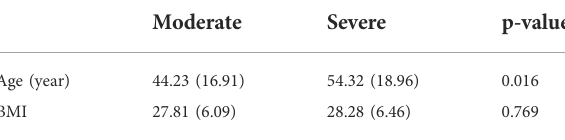
TABLE 2 Distribution of age and BMI among the disease groups (severe and moderate). Data show mean value (standard deviation) and p values were calculated based on two independent sample student t